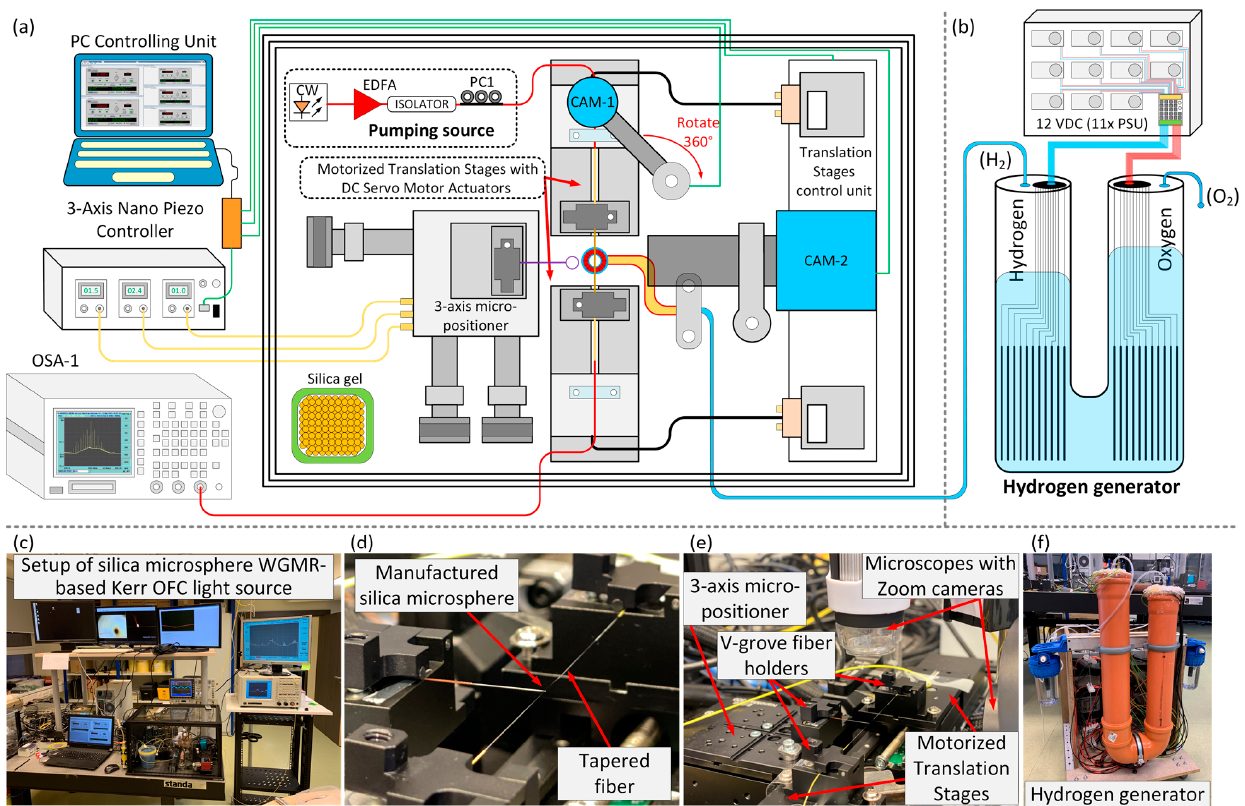
Figure 2. ( a ) Experimental setup illustrating the developed silica microsphere WGMR-based Kerr- OFC as a light source for optical communications. ( b ) Schematic of a Hydrogen generator for pure generation of hydrogen (H 2 ) and oxygen (O 2 ) by electrolysis of water. ( c ) Captured setup of silica microsphere WGMR-based Kerr-OFC light source. ( d ) Tapered fiber and silica microsphere resonator positions inside of enclosure box for dust and airflow prevention. ( e ) The 3-axis X, Y, and Z micro- positioner stage with a built-in Piezo controller and compact, motorized translation stages together with zoom microscopes used to monitor the position of the WGMR resonator. ( f ) Captured hydrogen generator for pure hydrogen and oxygen production.